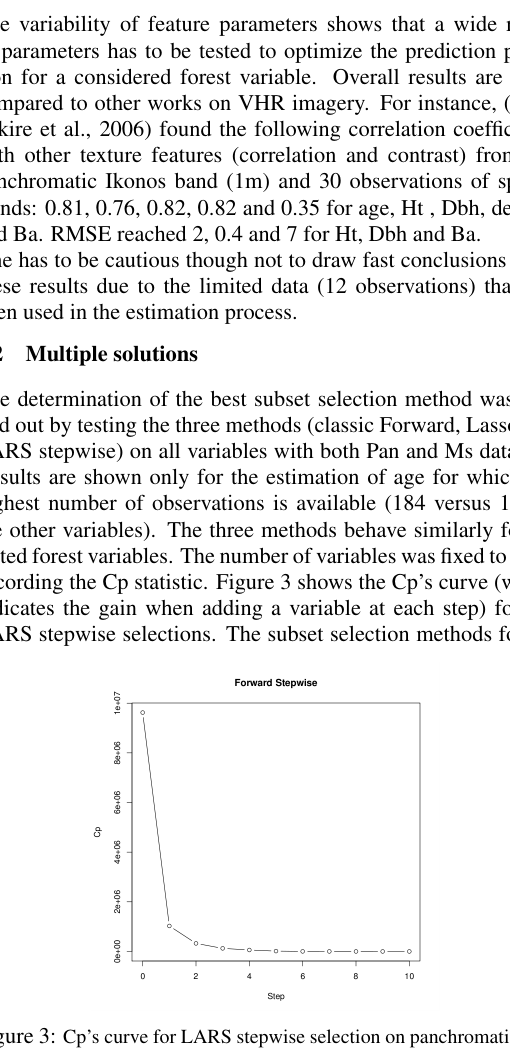
Figure 3: Cp’s curve for LARS stepwise selection on panchromatic data